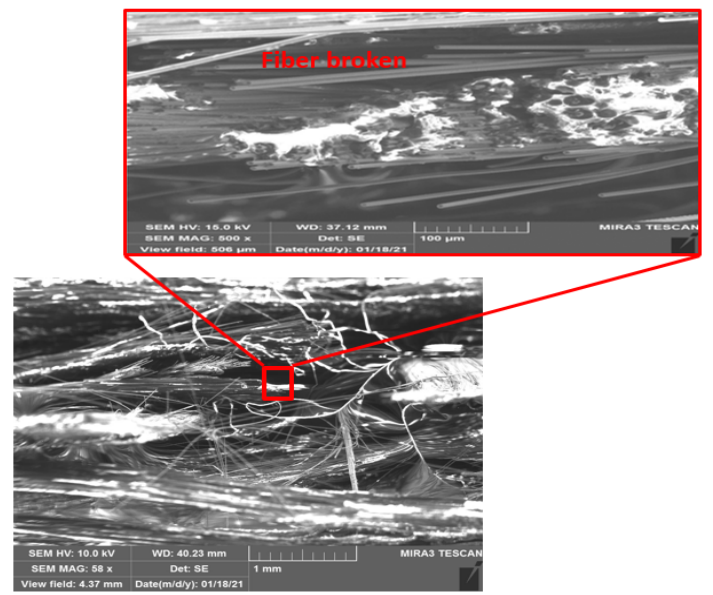
Figure 22. SEM observation of C-SMC.